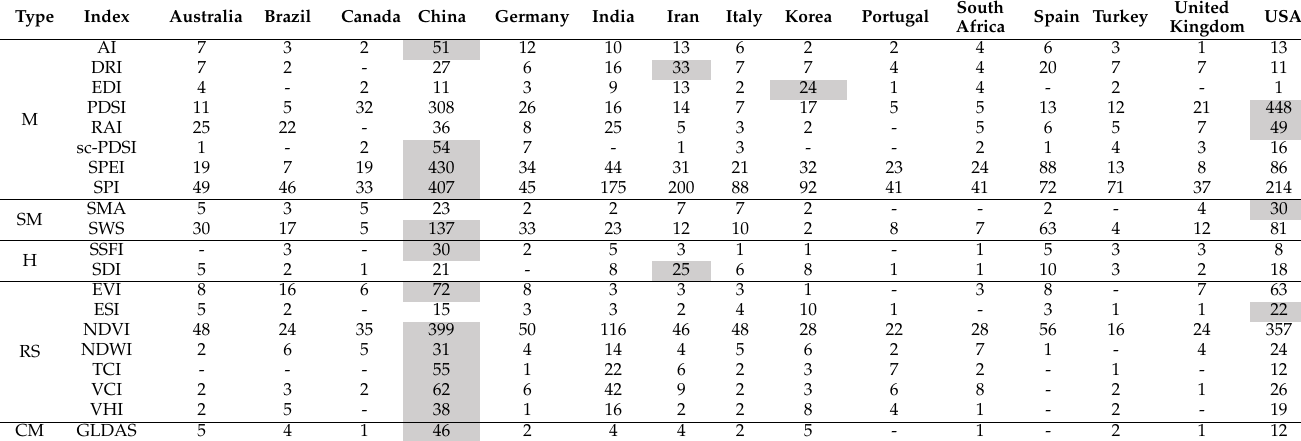
Table 3. Top 20 DIs used in different countries and the number of publications in each country.